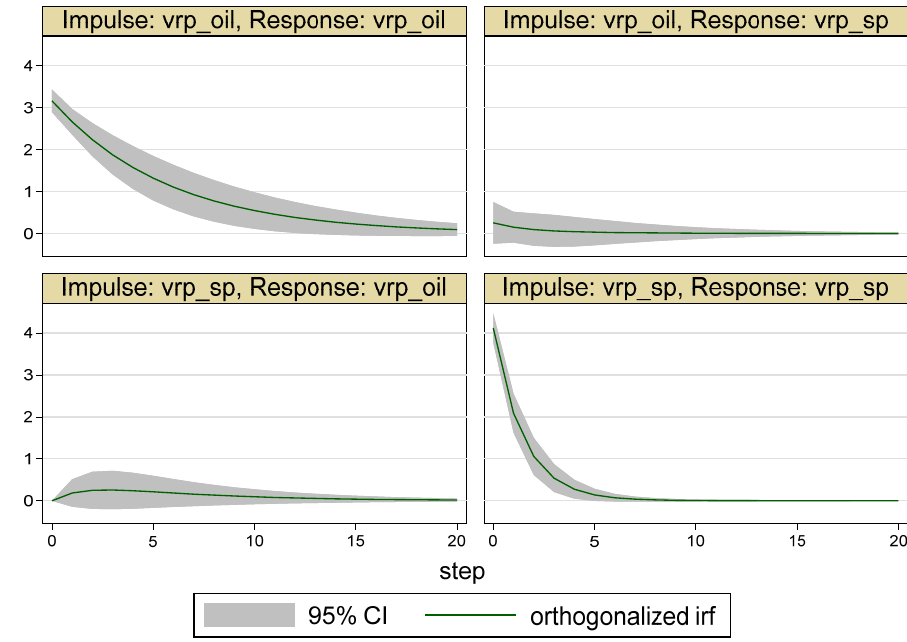
Figure 4. Impulse Response Function (Period 1).